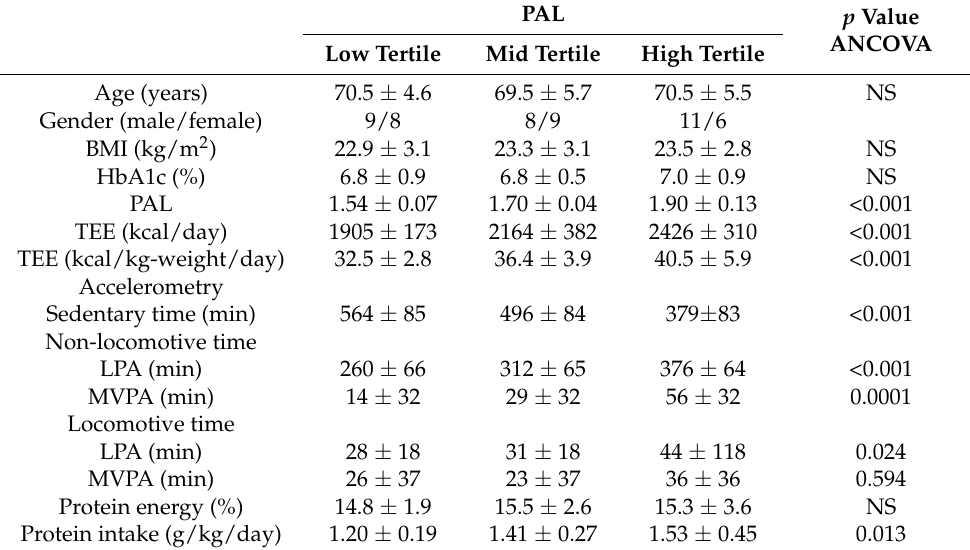
Table 2. The total energy expenditure, activity time, and estimated protein intake among subjects with type 2 diabetes mellitus with a low, middle, and high physical activity level